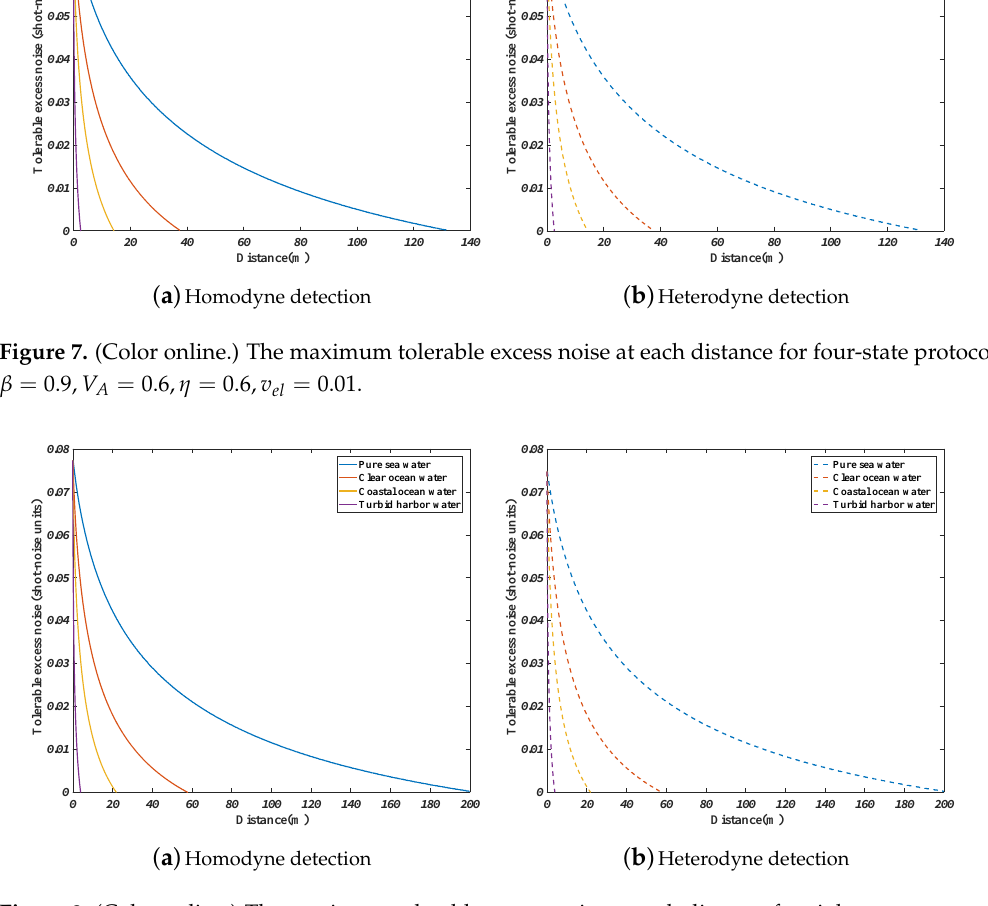
Figure 8. (Color online.) The maximum tolerable excess noise at each distance for eight-state protocol. β = 0.9, V A = 0.6, η = 0.6, v el =